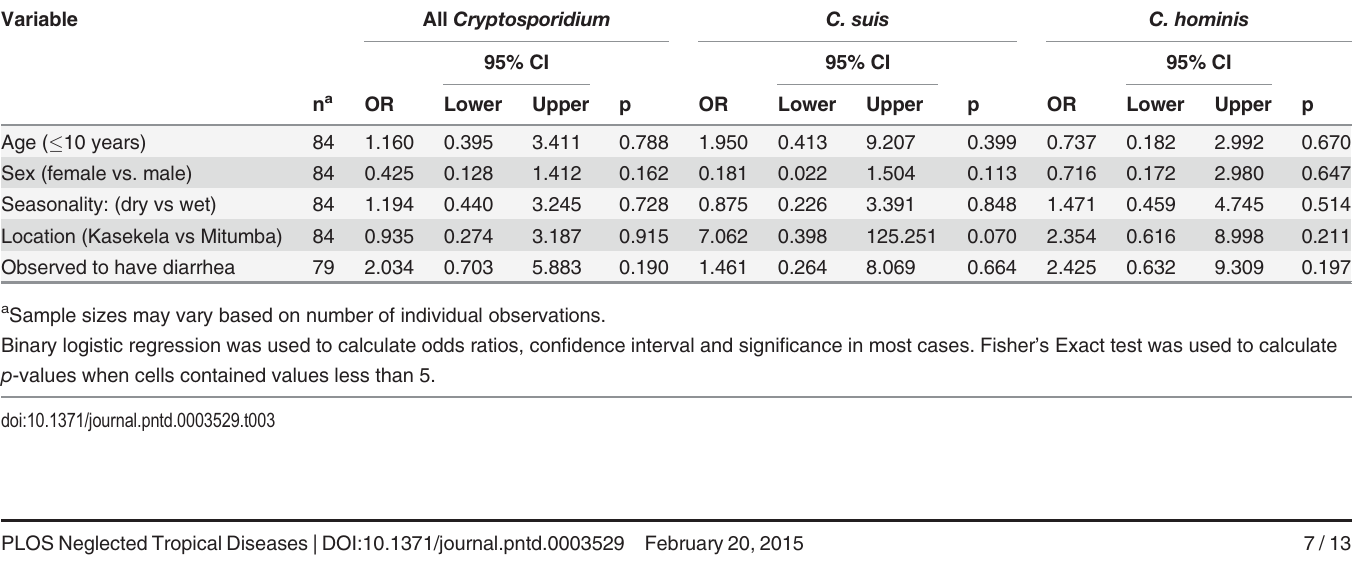
Table 3. Risk factors for Cryptosporidium infection in chimpanzees in Gombe National Park, Tanzania. Variable All